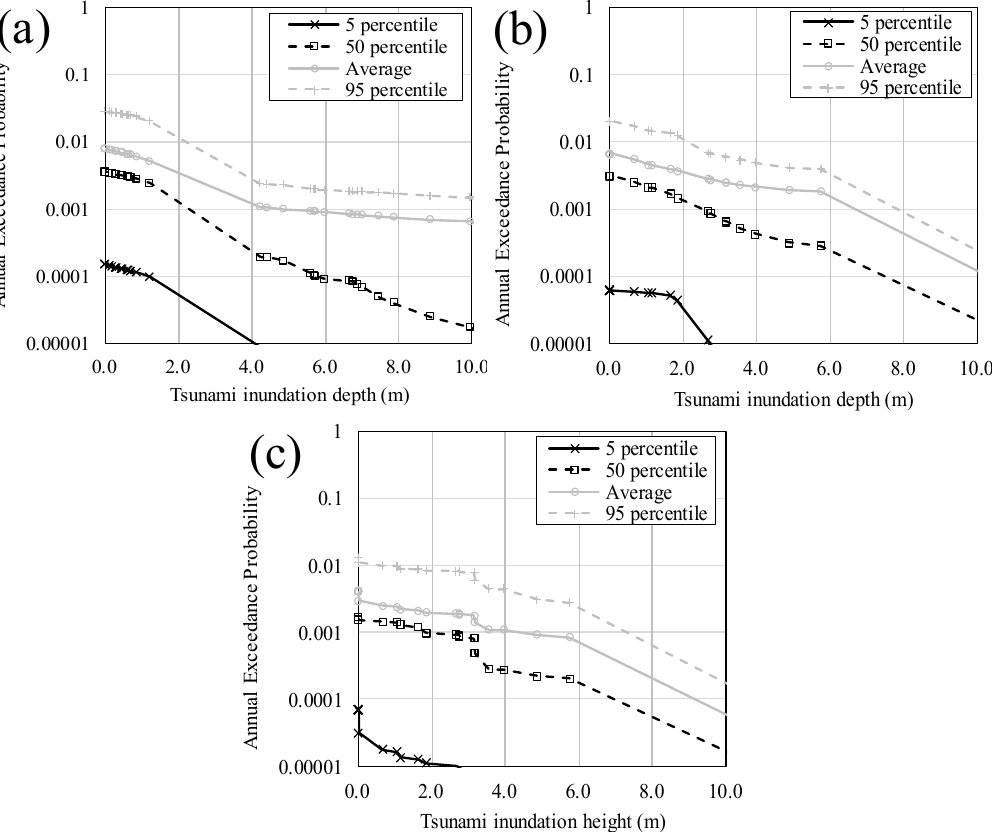
Figure 12. Relationships between the annual exceedance probability and tsunami inundation height for ( a ) Soma; ( b ) Sendai and ( c ) Kesennuma.